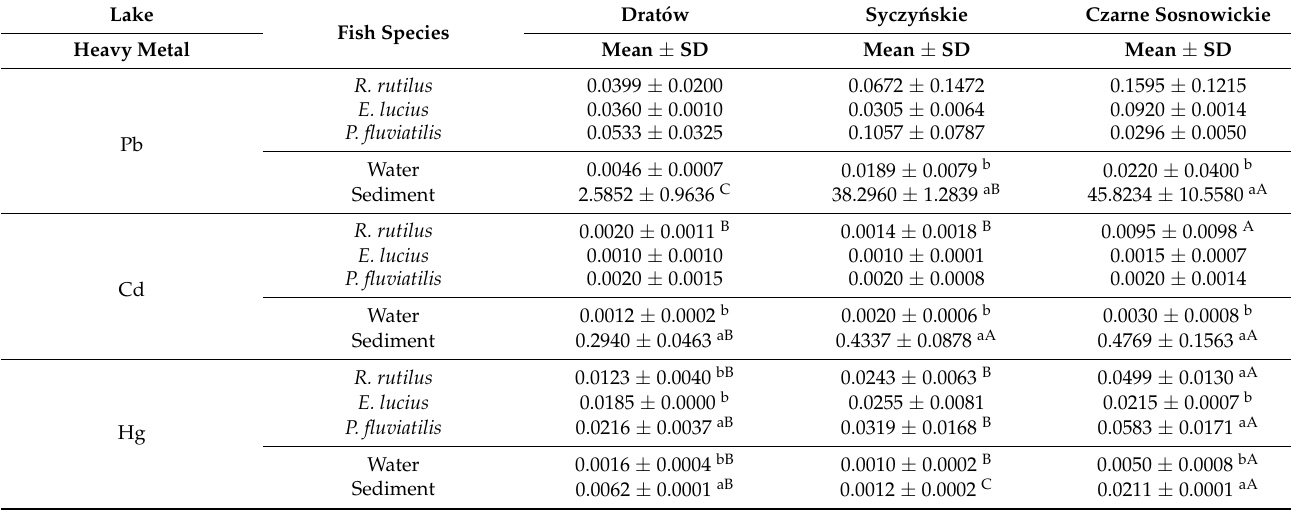
Table 4. The contents of Pb, Cd, and Hg in water (in mg dm − 3 ), sediment and fish muscles (in mg kg − 1 ) from studied lakes.